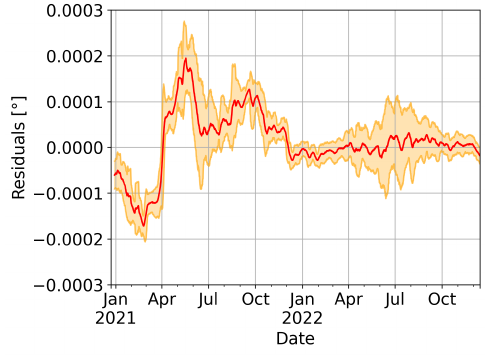
Figure 12. Iterative model: T2 residuals.